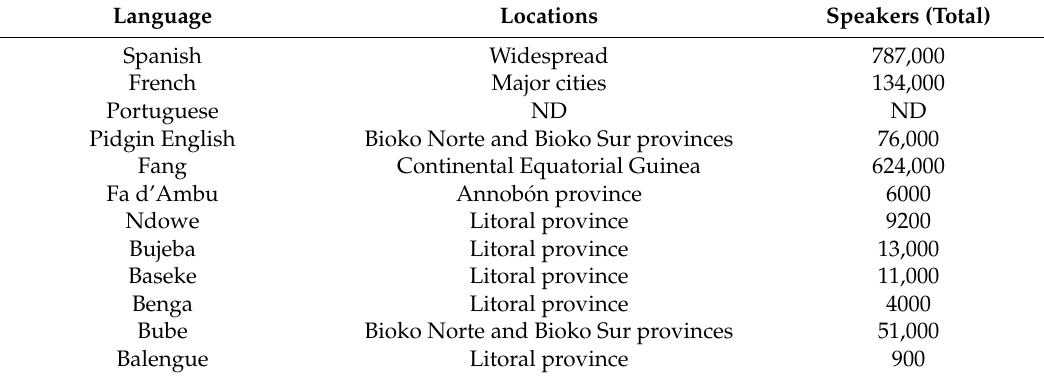
Table 1. Language Users (including first and second languages speakers) in Equatorial